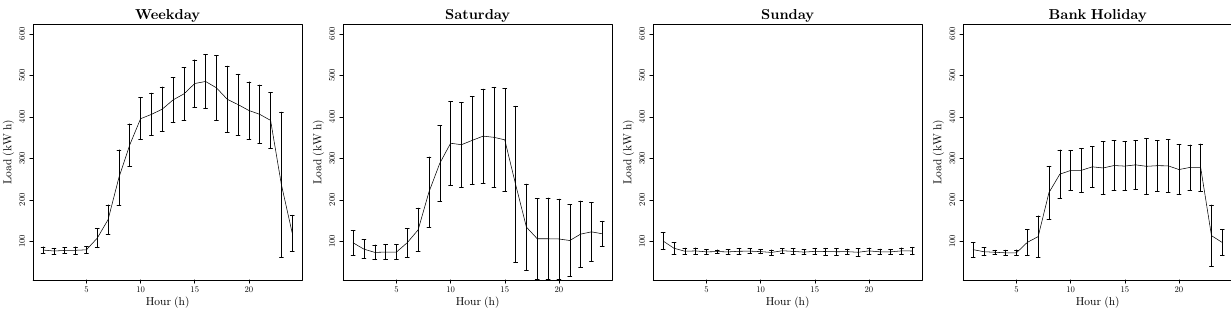
Figure 4. Typical load for the dataset with three day-types. Average daily load ( kW h ). Error bars denotes ± σ . ( a ) Dataset bilbao